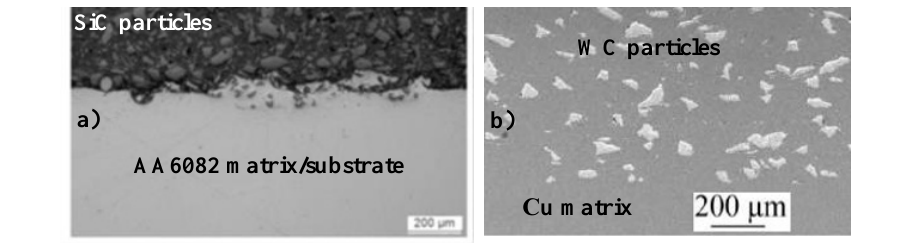
Fig. 1. Microstructure of “metal matrix – carbide particles” composite coatings: а) [1], b) [2] .